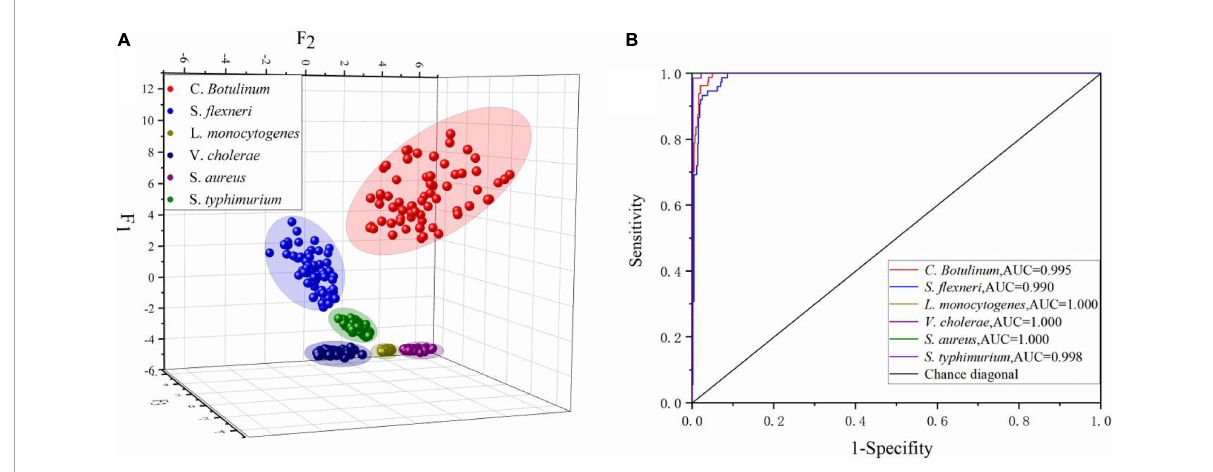
FIGURE7 (A) All-Groups 3D scatter plot and (B) the ROC curve of the FDA model using the SG 1st Der.